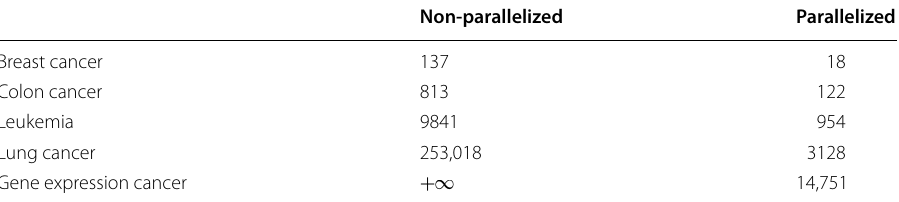
Table 9 SDPSO runtime for the five datasets (s) Non-parallelized Parallelized Breast cancer 137 18 Colon cancer 813 122 Leukemia 9841 954 Lung cancer 253,018 3128 ∞ Gene expression cancer +